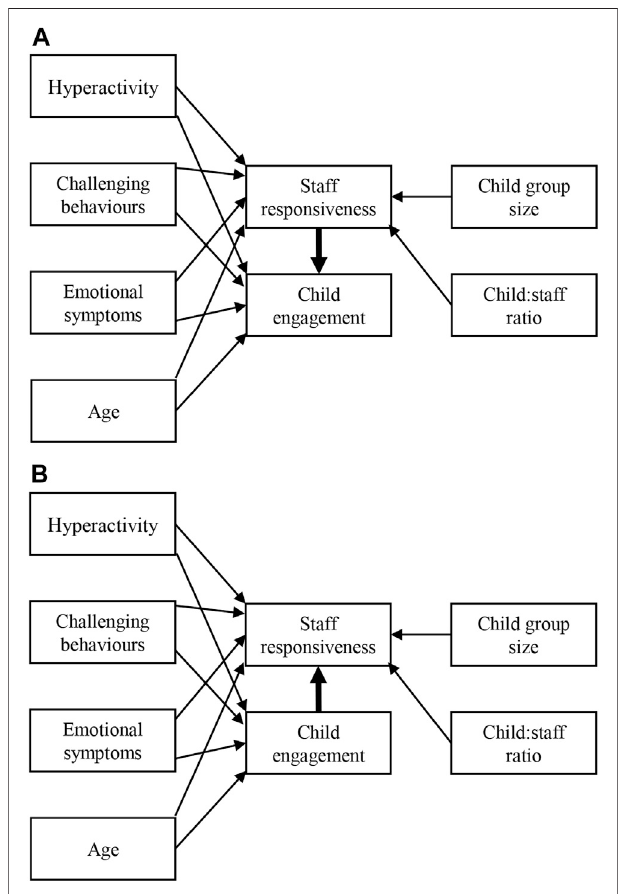
FIGURE 1 | (A) Suggested model child engagement. The bold arrow shows where the models differ. (B) Suggested model staff responsiveness. The bold arrow shows where the models